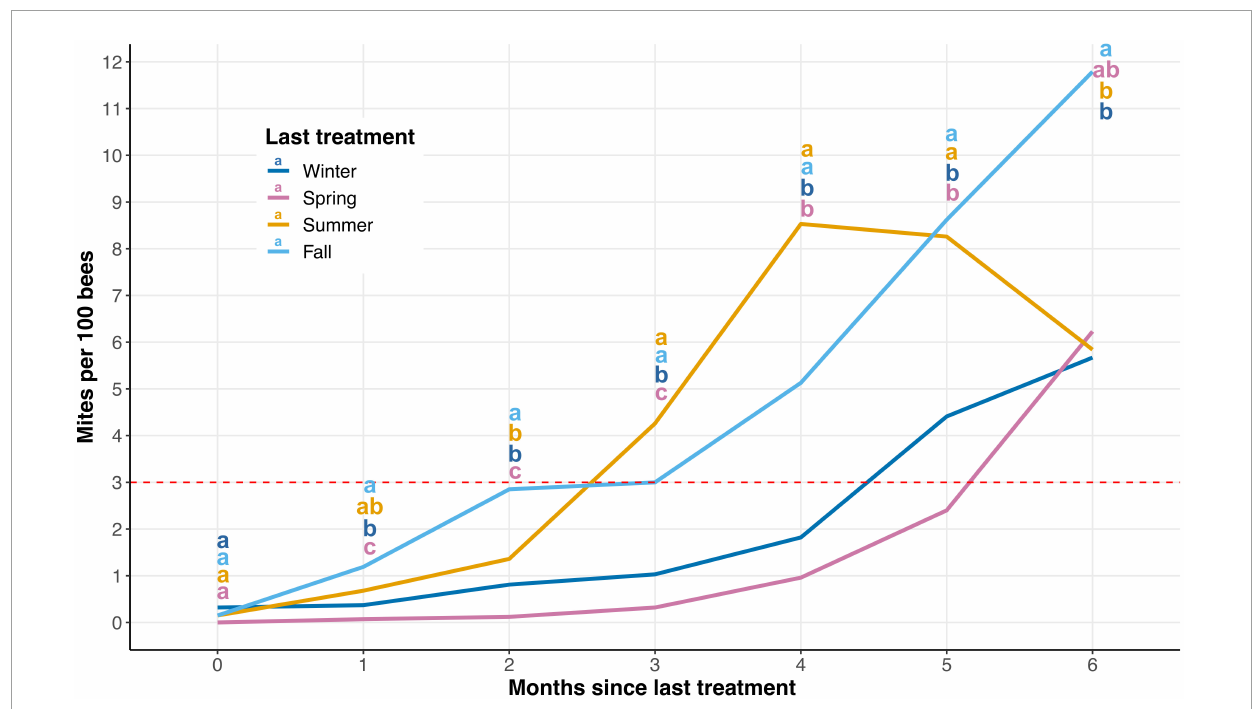
FIGURE2 Average Varroa destructor population growth expressed as number of mites/100 bees after 6 months for each season. These results combine data from both trials 1 and 2. The dashed red line represents the standard economical threshold of 3 mites/100 bees. There was a significant impact of season treatment was administered on the mites/100 bees ( P ≤ 0.05). Significant differences between means are indicated with different letters ( α = 0.05; a > b >